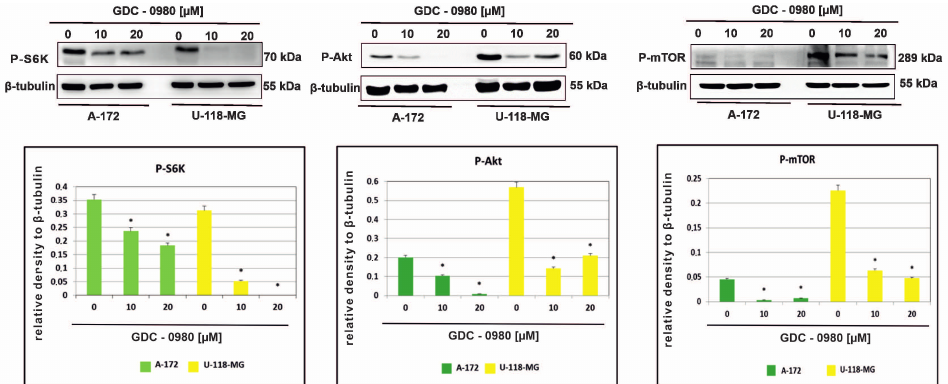
Figure 5. GDC-0980 inhibits PI3K pathway signalling in A-172 and U-118 MG glioblastoma cell lines. Western blot data show the relative densities of P-S6K Thr421/Ser424 , P-AKT Ser473 , and P-mTOR Ser2448 to β -tubulin after 48 h of GDC-0980 treatment. β -tubulin (50 kDa) was used as a sample of loading control. Samples containing 20 µ g of protein were submitted to electrophoresis and immunoblotting. The representative bands of the P-S6K Thr421/Ser424 , P-AKT Ser473 , and P-mTOR Ser2448 to β -tubulin are illustrated. Data are presented as the means ± SEM. * p < 0.05.